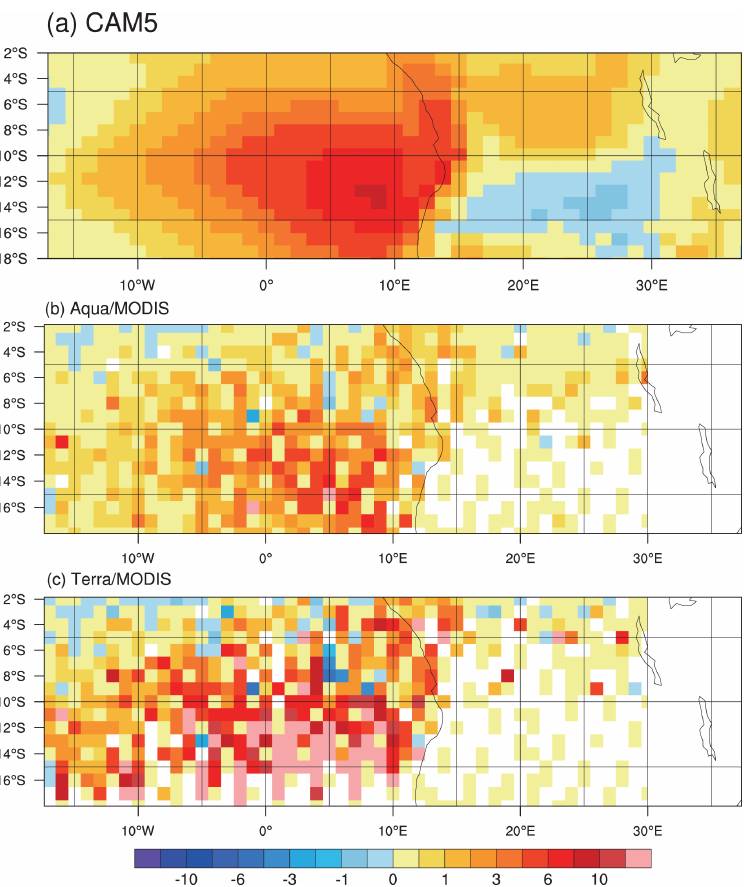
Figure 5. (a) September–October–November (SON) mean fire aerosol radiative effects due to aerosol–radiation interactions (REari) (Wm − 2 ) for the period of 2003–2011 over the southeast Atlantic Ocean due to all fire aerosols. Panels (b, c) are the same as (a) , but for the above-cloud aerosol REari for the period of 2007–2011 estimated using Aqua/MODIS and Terra/MODIS products (Zhang et al.,